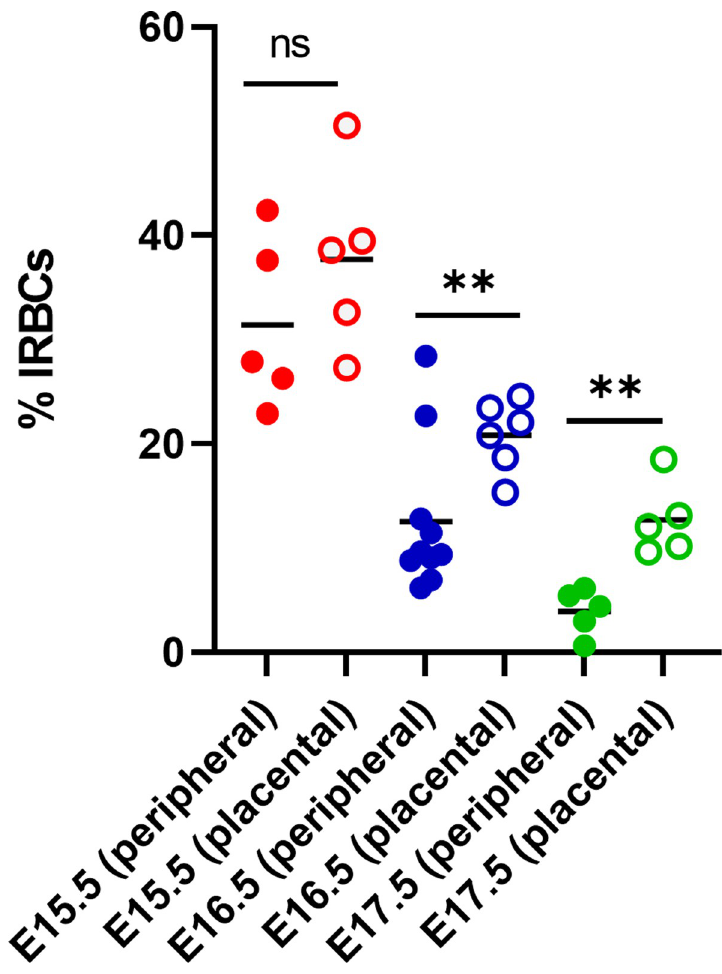
Fig 2. P . chabaudi AS-infected red blood cells accumulate prior to preterm delivery in the placentae of mice infected at E8.5 and E10.5. Peripheral and placental parasitemia from mice infected on E6.5 (red), E8.5 (blue) and E10.5 (green), sacrificed at E15.5, E16.5 and E17.5, respectively. �� P < 0.002, unpaired t-test with Welch’s correction; ns = not significant, P >